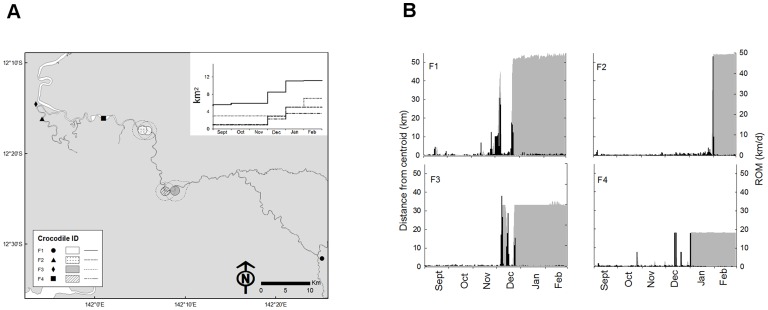
Movement patterns of female Crocodylus porosus.(a) The KUD 50% and KUD 95% (dotted boundary) calculated from GPS-location fixes recorded between 01 September and 28 February (n = 4). Inset graph shows the monthly cumulative KUD 95% for each individual. (b) The relationship between daily rate of movement (ROM) and daily distance from the KUD 50% centroid (grey  =  primary y-axis; black  =  secondary y-axis).